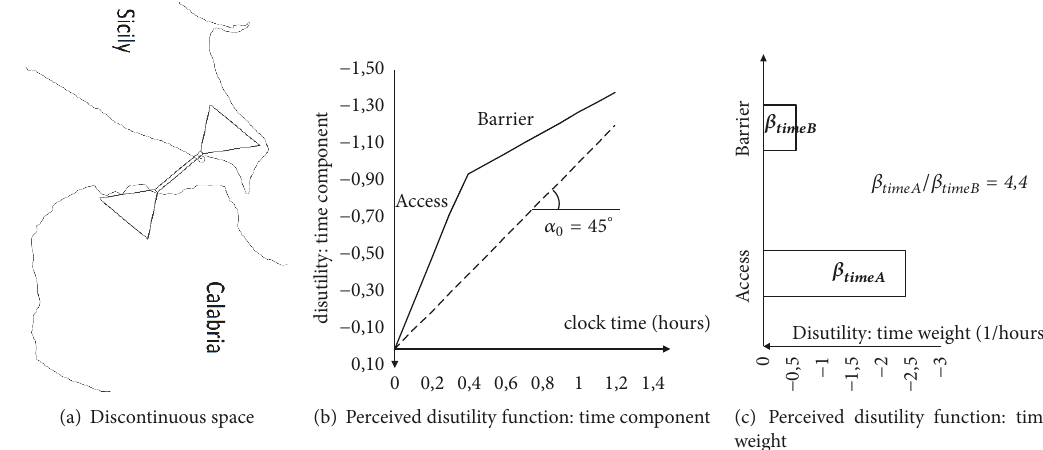
Figure 3: Travel in discontinuous space: The case